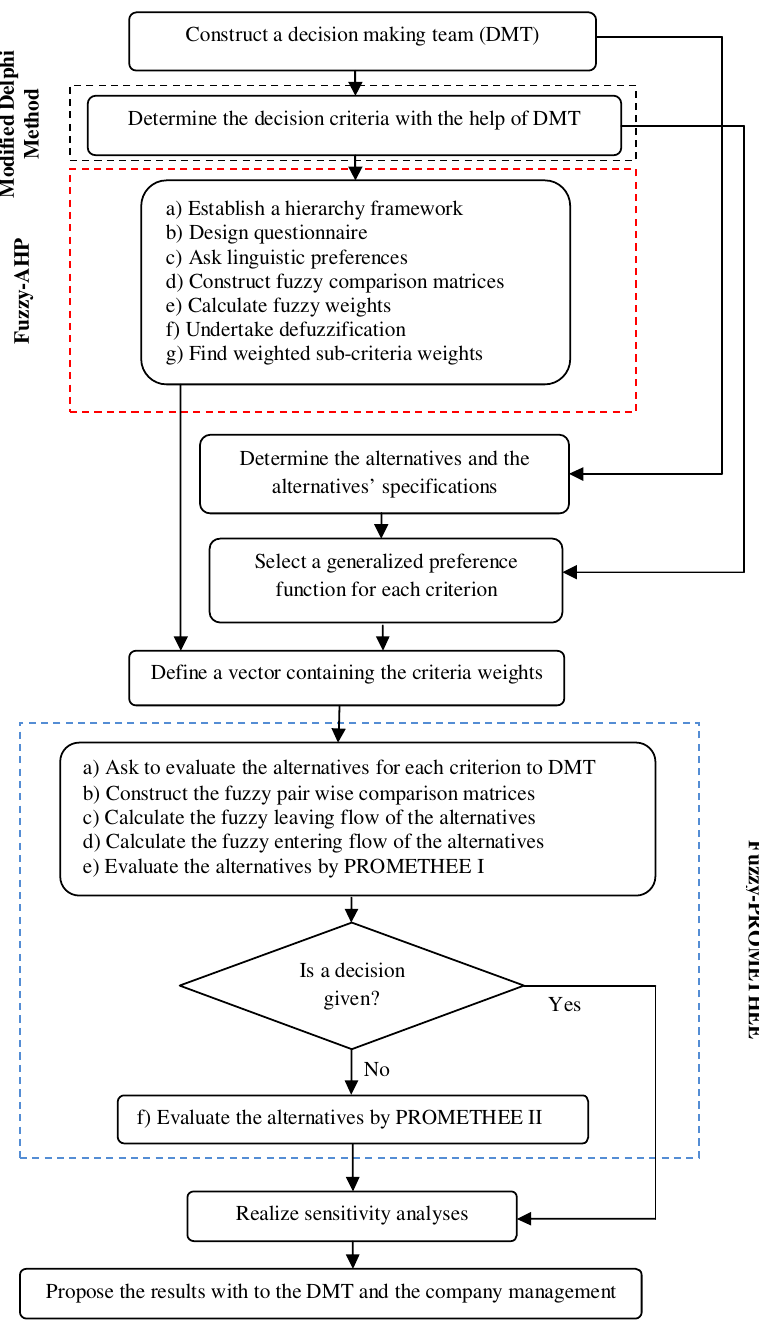
Figure 2. Proposed integrated fuzzy multi-criteria decision making